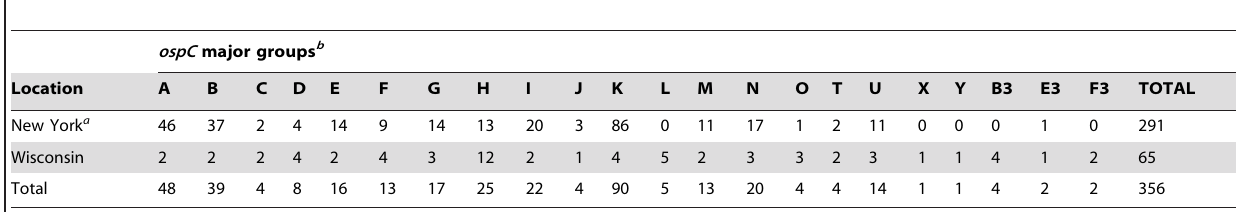
Table 1. Geographical distribution of B. burgdorferi ospC major groups found in skin of Lyme disease patients from New York and Wisconsin.